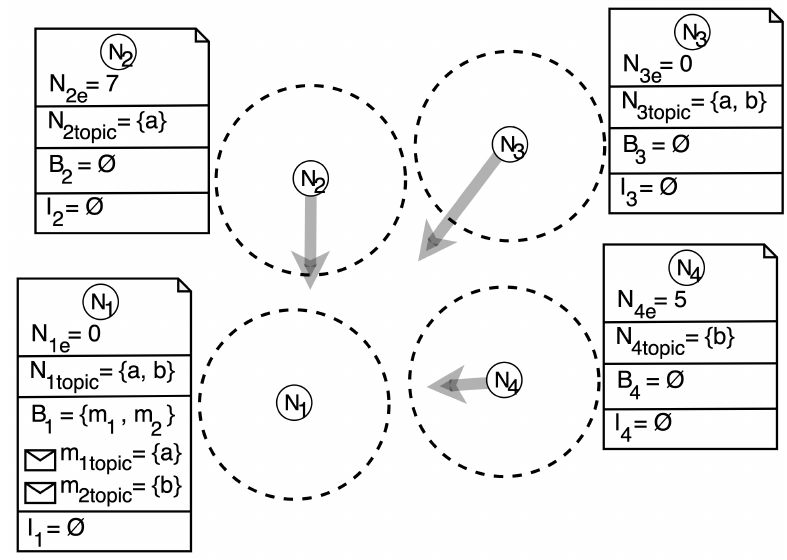
Figure 1. Scenario before the sender node transmits